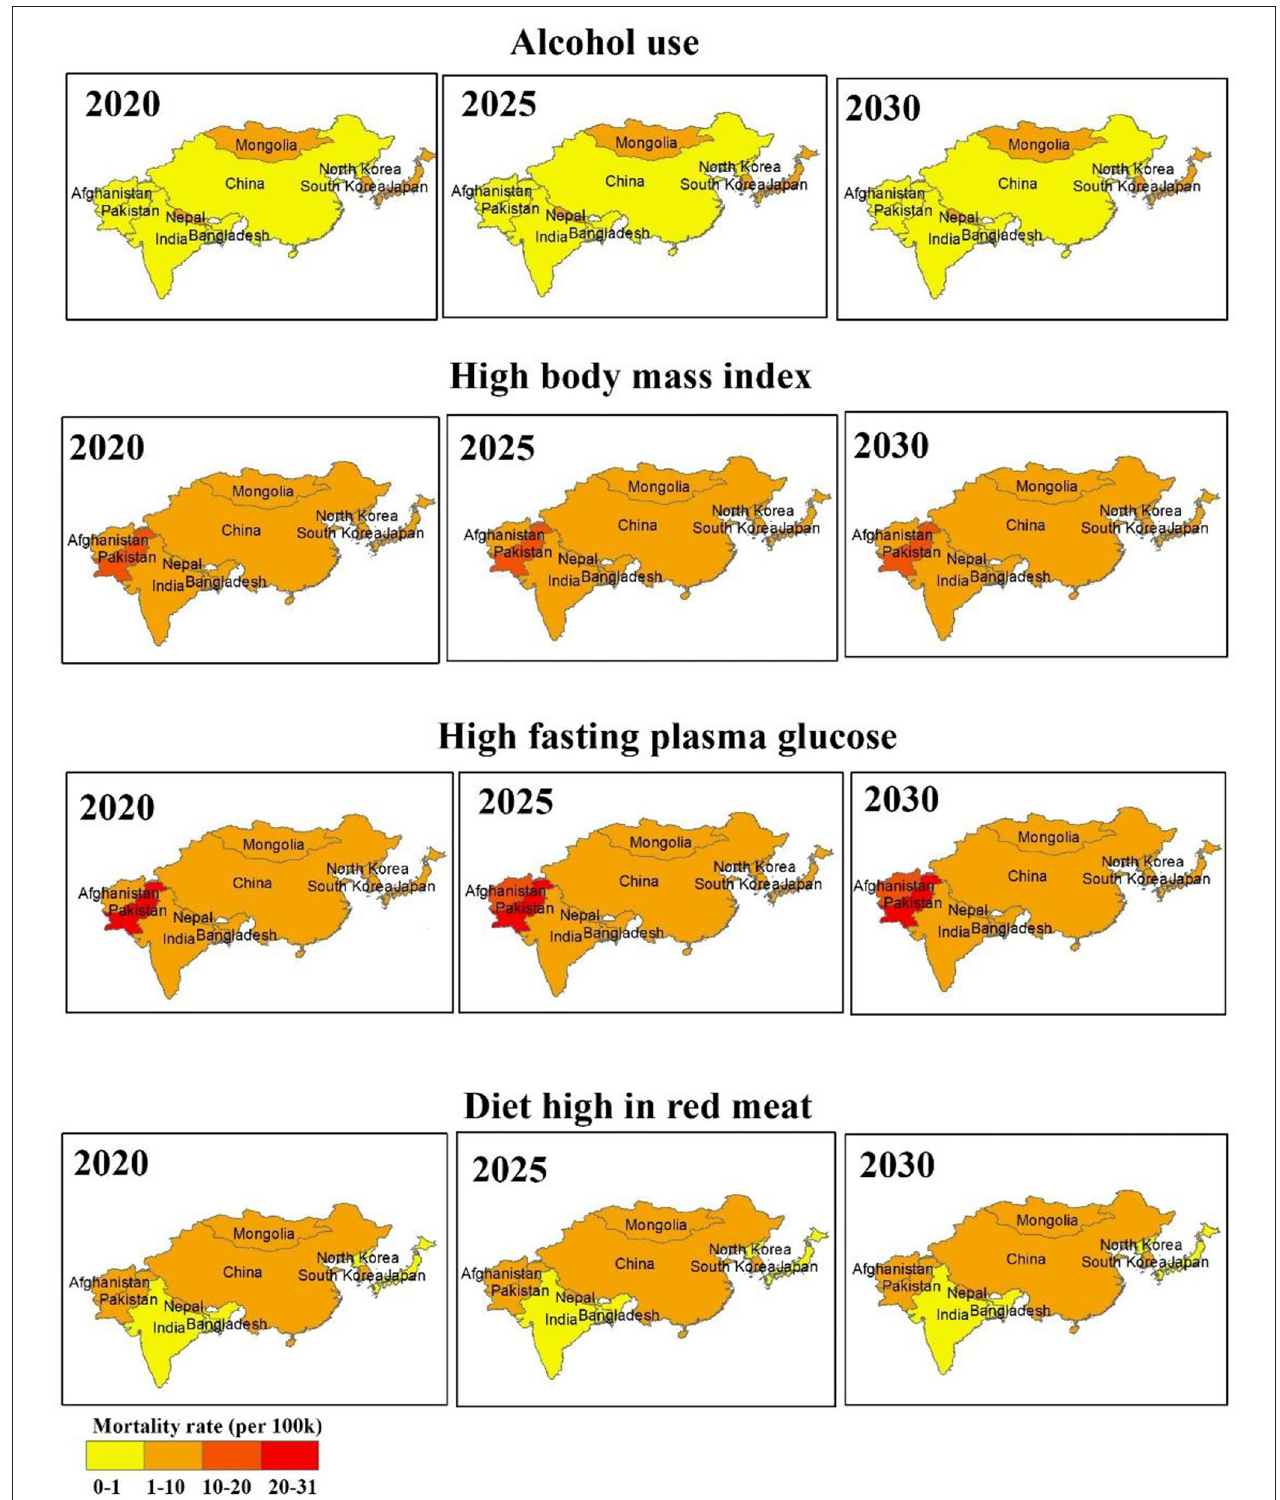
FIGURE 3 | Regional disparity of mean predicted risk attributable mortality rates (per 100k) for the female of aged 50–84 years old, for the year 2020, 2025, and 2030.